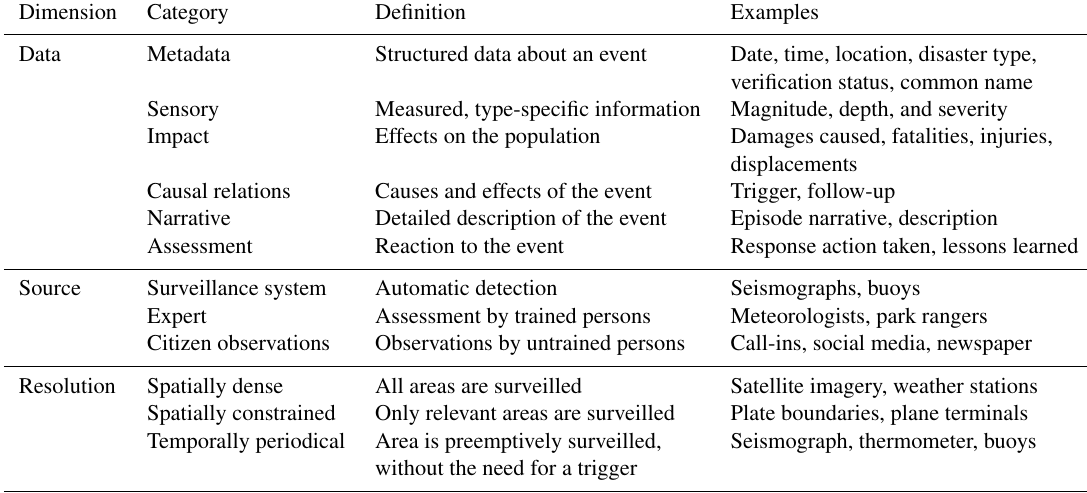
Table 2. Taxonomy of the information commonly collected about